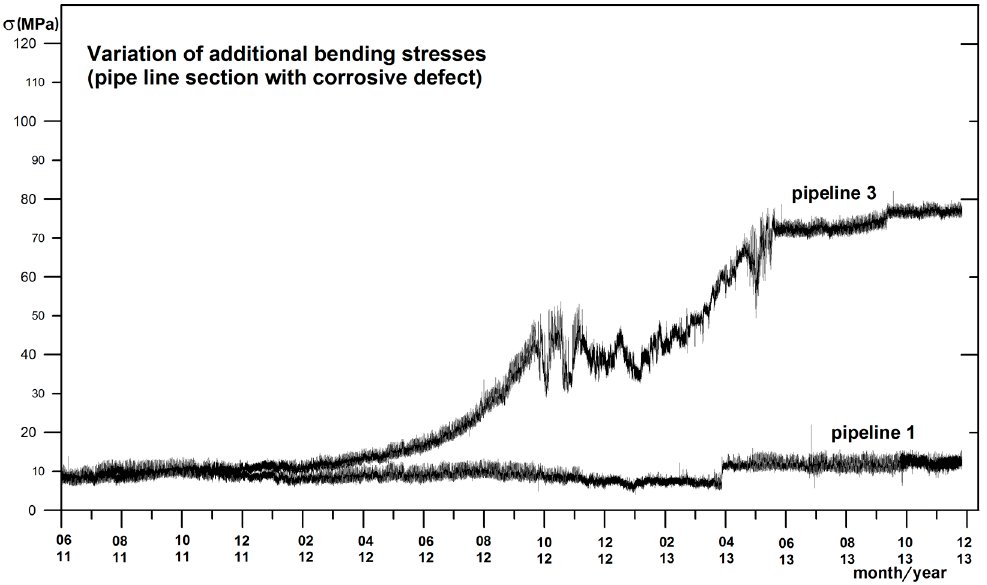
Figure 9. Gradual rise of stresses from additional bending stresses on the pipeline.